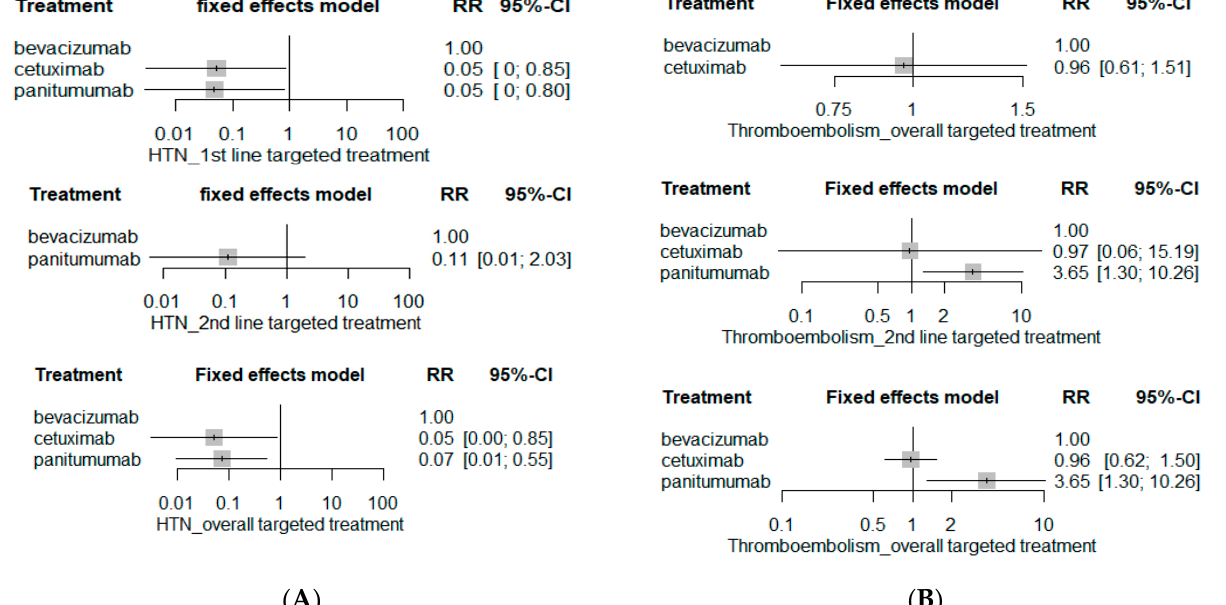
Figure 6. Neurological SAE risk. ( A ) Fatigue; and ( B ) peripheral neuropathy.